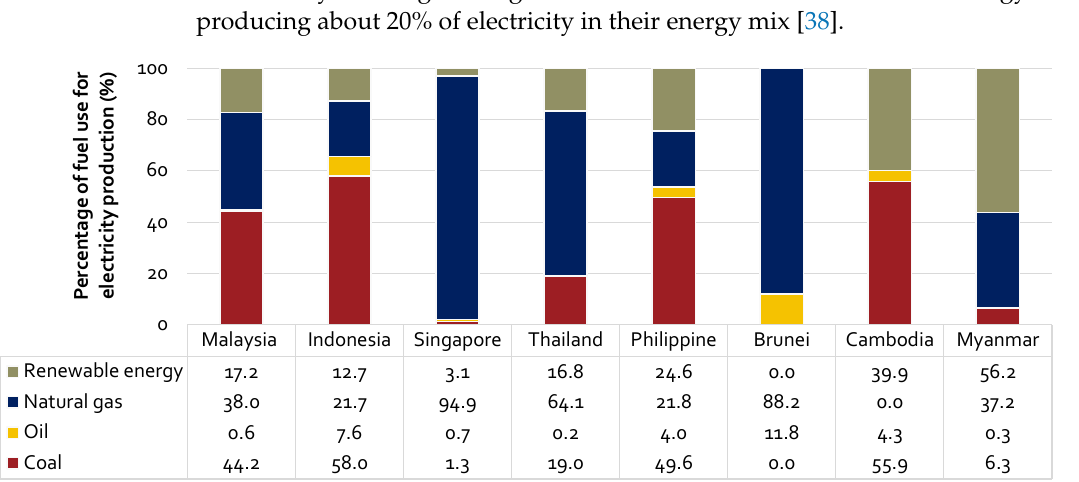
Figure 2. Percentage of energy inputs use for electricity production (%) in ASEAN countries in 2017